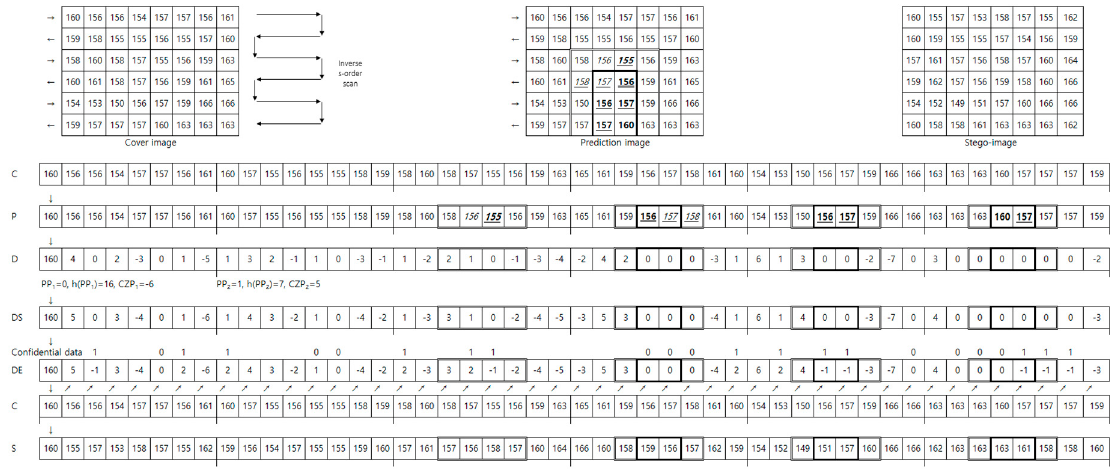
Figure 11. An example of data embedding using the ARDHA technique.